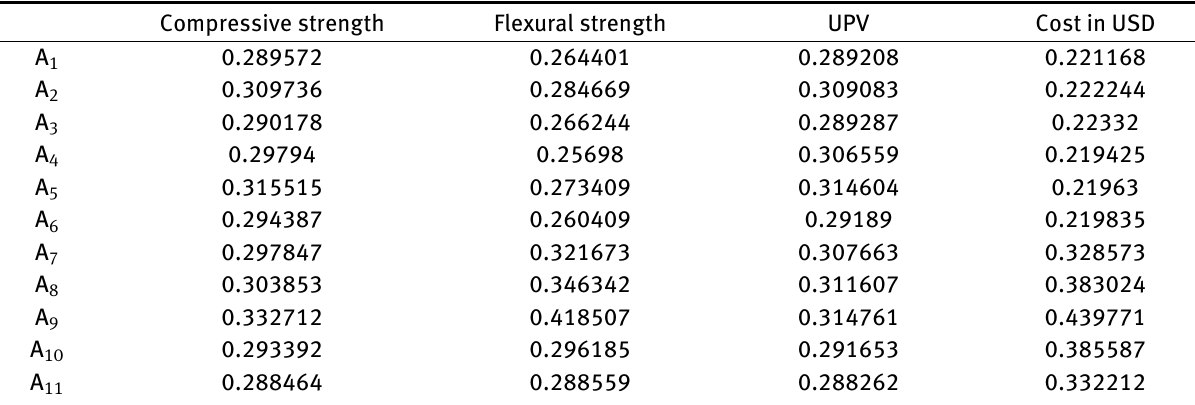
Table 17: Normalized decision matrix ( V ) obtained from TOPSIS method for reinforced green